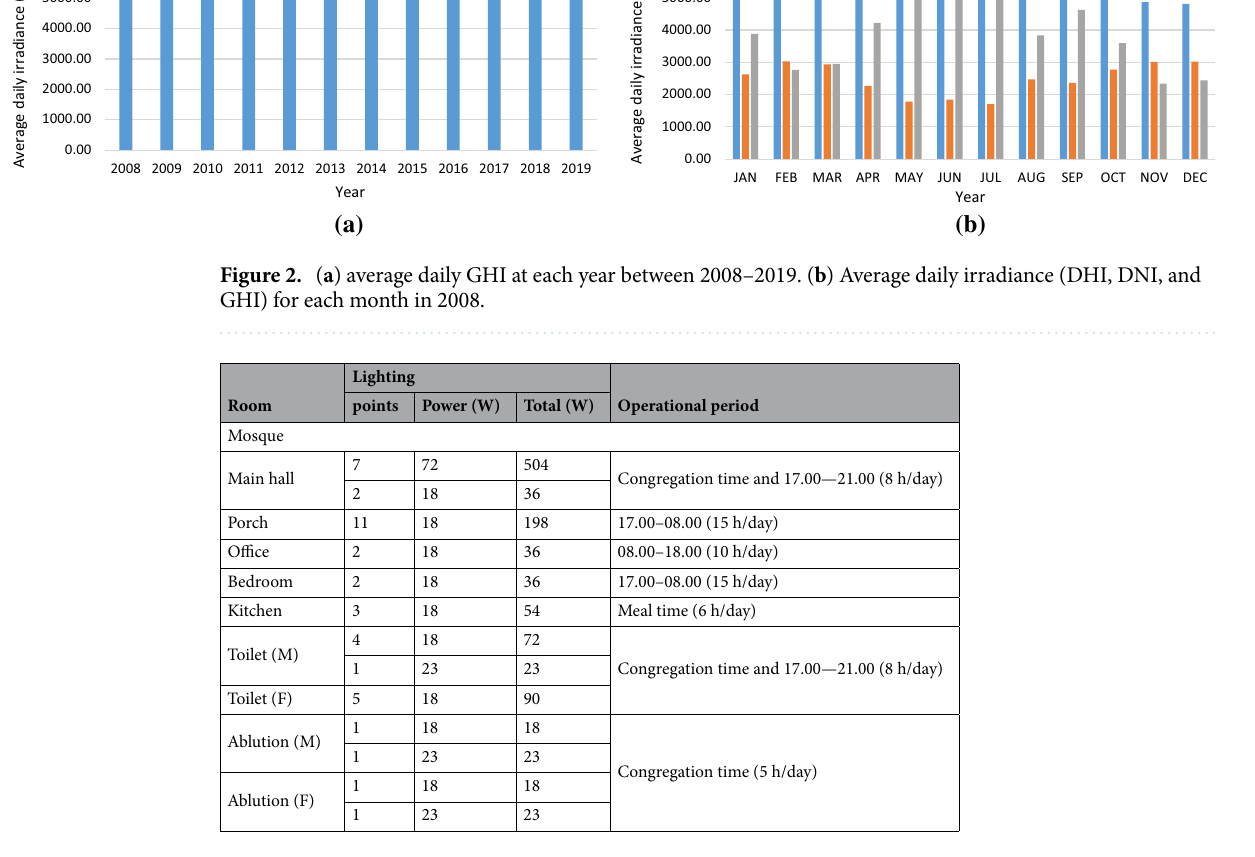
Table 2. Lightings number, power, location, and operational period.